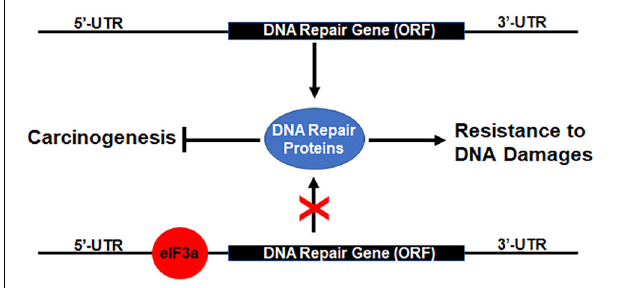
FIGURE 7 | Hypothetical model of eukaryotic initiation factor (eIF)3a regulation of DNA repair protein synthesis relationship with DNA damage resistance and tumorigenesis. Binding of eIF3a to 5 (cid:48) -untranslated regions (5 (cid:48) -UTRs) of mRNAs encoding DNA damage repair proteins inhibits translation and synthesis of DNA repair proteins, leading to sensitization of cancer cells to DNA-damaging treatments and susceptibility of normal cells to DNA-damaging